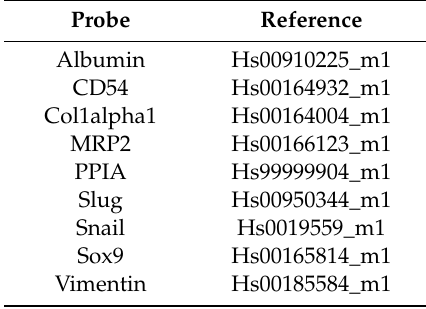
Table 3. Taqman probes used for RT-qPCR